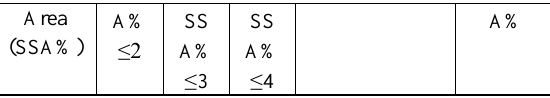
Table 2. Microstructure parameters variation